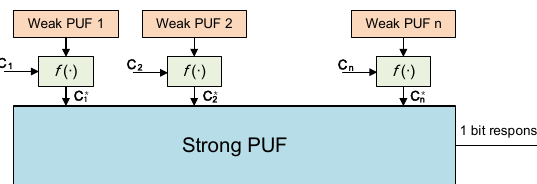
Figure 2. The architecture of the previously proposed XMPUF